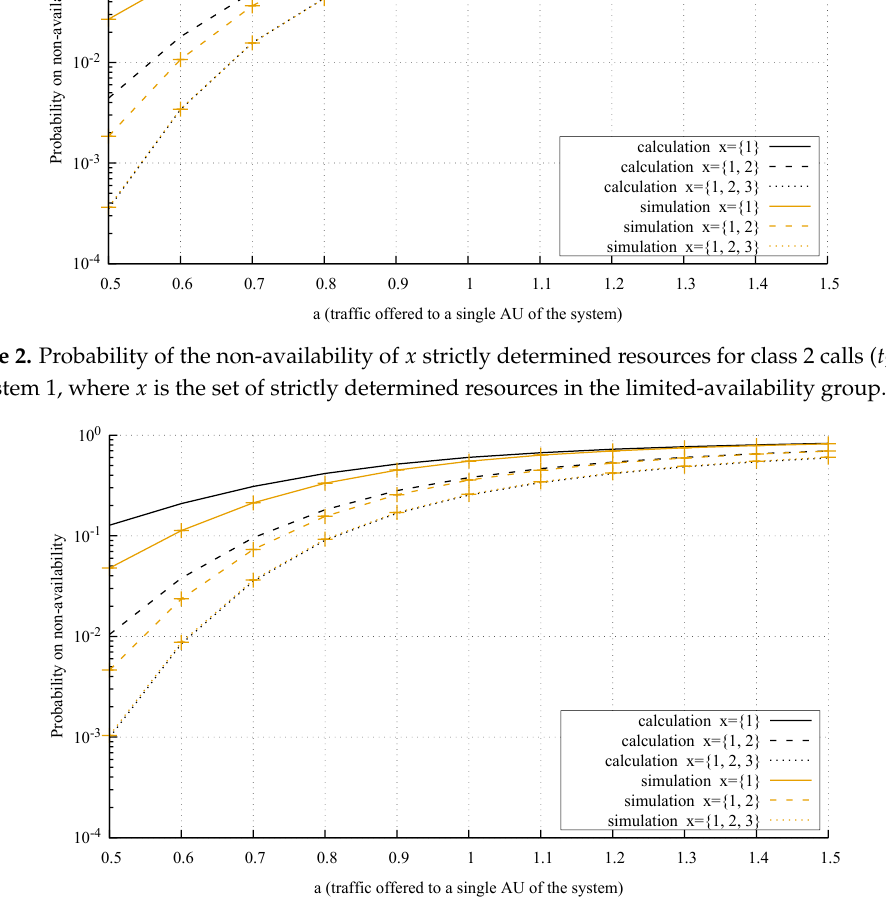
Figure 3. Probability of the non-availability of x strictly determined resources for class 3 calls ( t 3 = 3) in System 1, where x is the set of strictly determined resources in the limited-availability